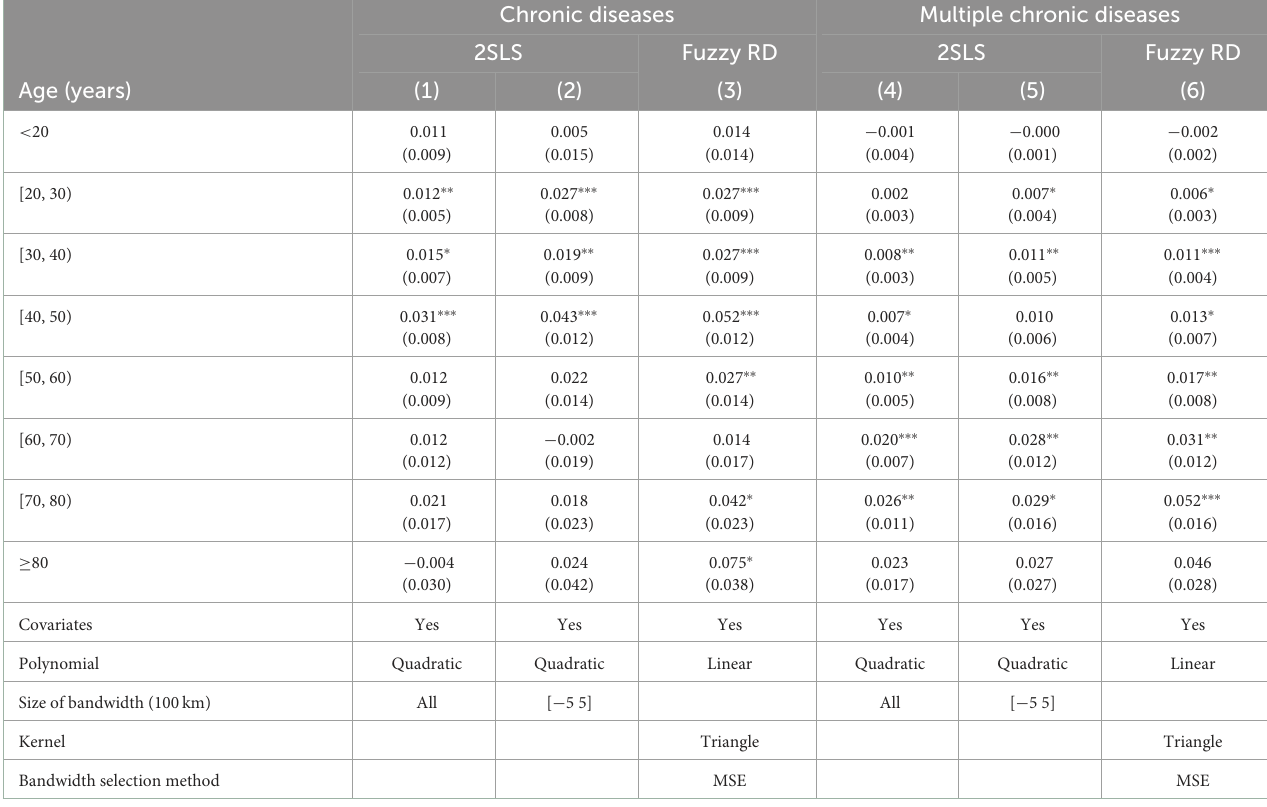
Eachcellinthetablerepresentsaseparateregression.InColumns(1)–(2)and(4)–(5),wereportthe2SLSIVestimateofPM 2.5 onthelistedoutcomesbyusing“NorthofHuaiRiver”astheIV,after controllingforaquadraticpolynomialindistancefromtheHuaiRiveranditsinteractionwithaNorthdummy.InColumns(3)and(6),weestimatetheeffectofPM 2.5 onthelistedoutcomeswiththe Huai River representing a “fuzzy” discontinuity at the level of PM 2.5 with a triangle kernel local linear regression, respectively, and the bandwidth selected by the common MSE-optimal bandwidth selector. Covariates from Table1 other than age are included in all regressions. Standard errors are presented in parentheses. ∗ Significant at 10% level; ∗∗ Significant at 5% level; ∗∗∗ Significant at